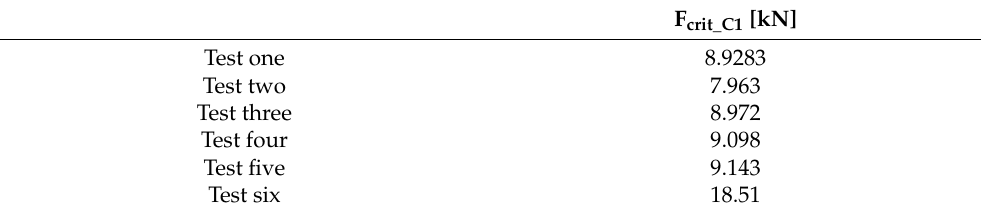
Table 4. Extracting the limit force at the weakest point of the harness for all test